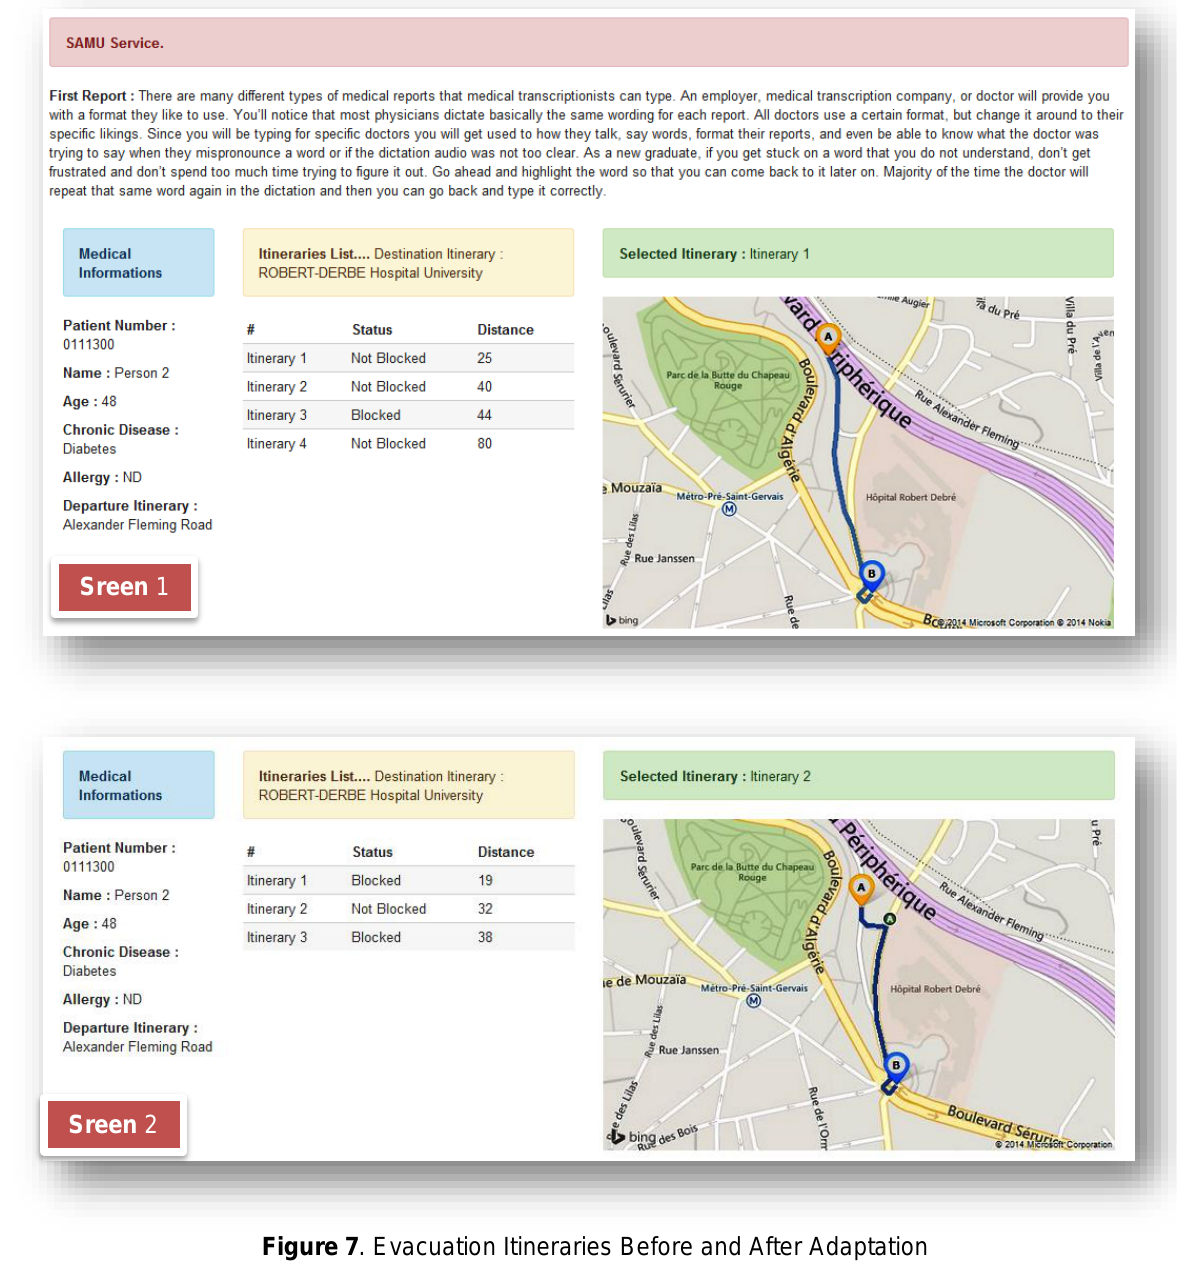
Figure 7 . Evacuation Itineraries Before and After